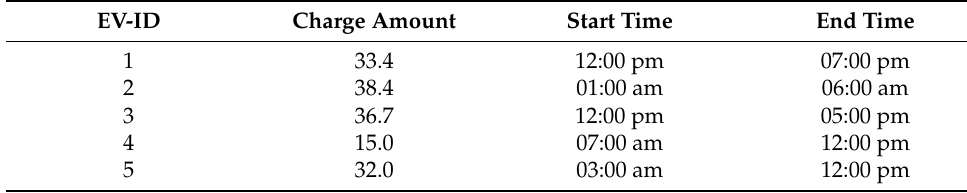
Table 5. EV scheduling results (scheduled charging amount and